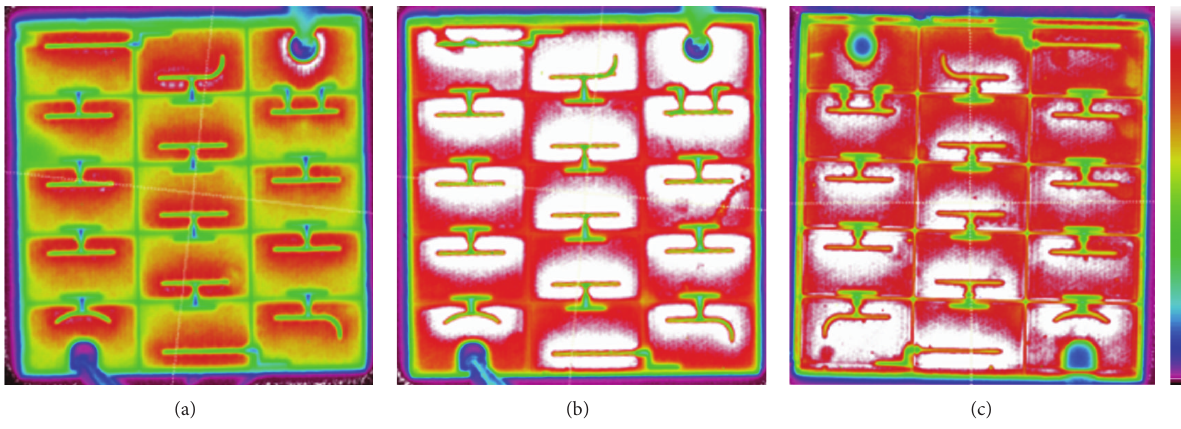
Figure 5: Light intensity distribution map of (a) the conventional HV-LED, (b) HV-LED + ODR, and (c)